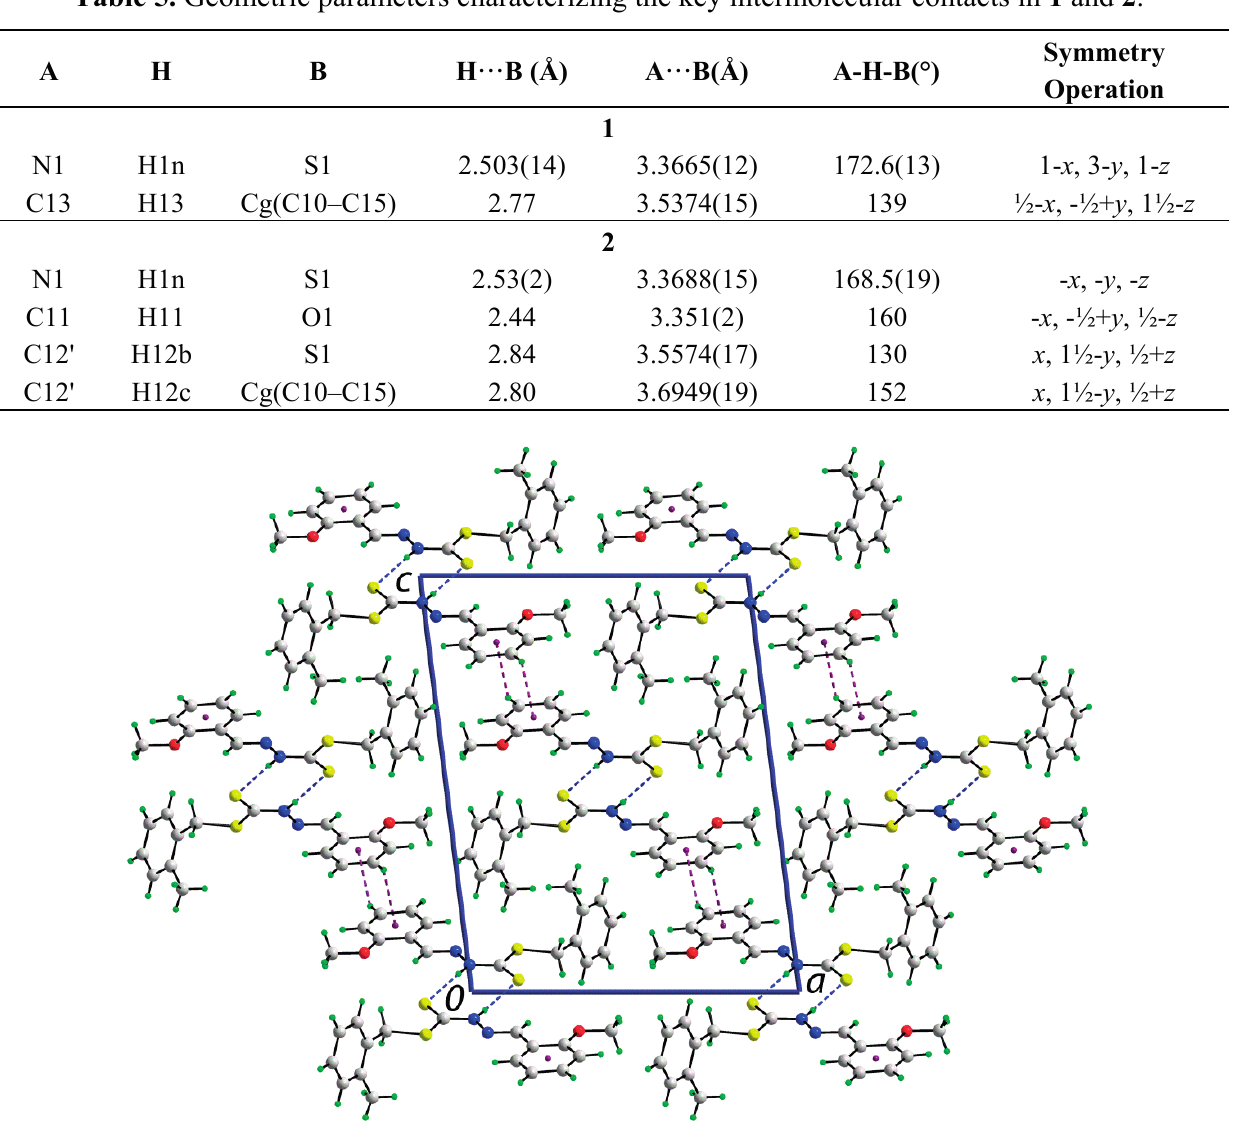
Figure 4. A view in projection down the b -axis of the unit cell contents of 1 . The N ‒ H···S and C ‒ H··· π interactions are indicated by blue and purple dashed lines,